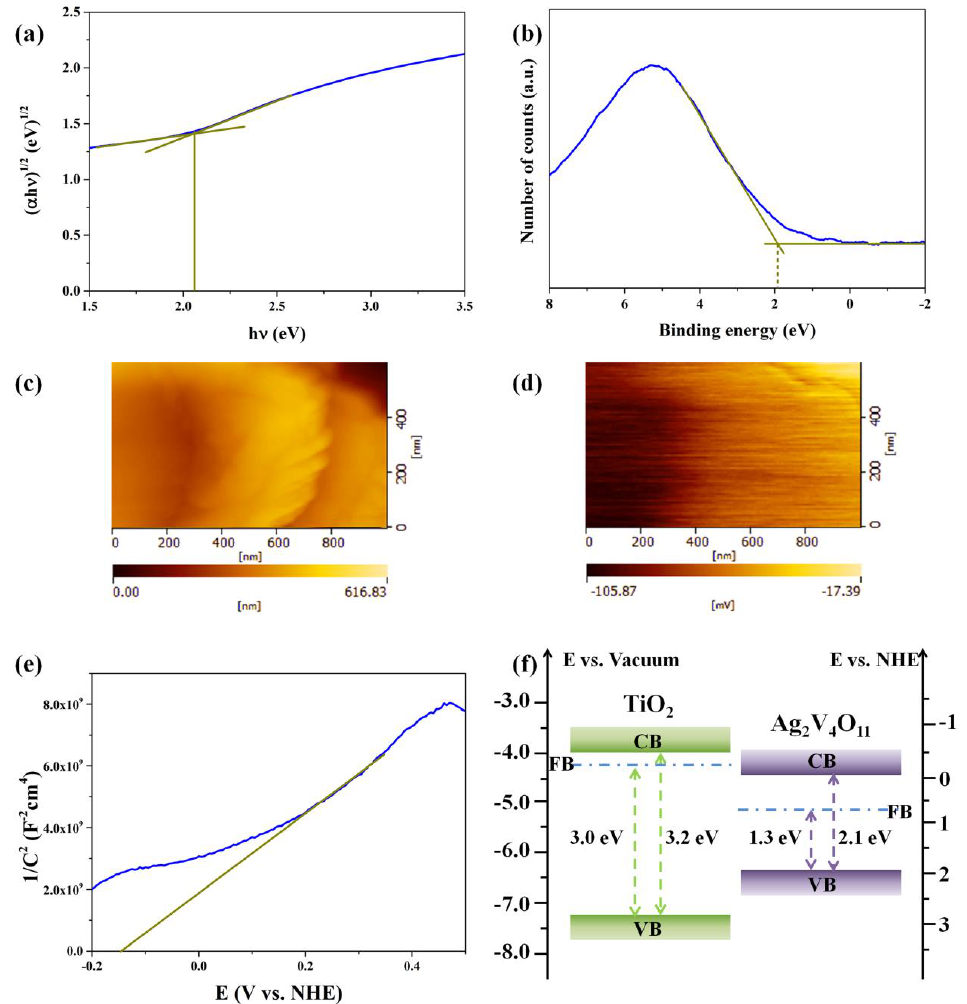
Figure 7. ( a ) The plot of (αhν) 1/2 vs. photo energy hν of A sample, ( b ) XPS valence band spectrum of A sample, ( c ) AFM images of the A sample deposited on a SiO 2 substrate, ( d ) Fermi energy level di ff erence between the Rh probe and Ag 2 V 4 O 11 using KPFM test, ( e ) Mott–Schottky plots of the A sample, ( f ) energy bands of the T and A